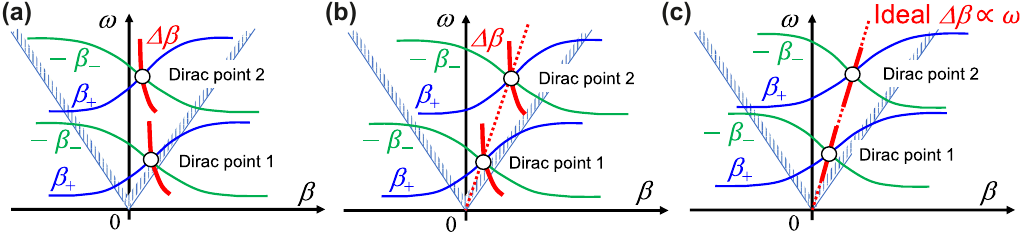
Figure 1: Schematic of typical dispersion diagrams of dual-band CRLH lines with two Dirac points and frequency dependence of the phase- shifting nonreciprocities Δ β . We here consider two conditions. Condition I is the case where both Dirac points in the lower and higher CRLH passbands are on the same linear line passing through the origin. Condition II is the case where both tangents of phase-shifting non- reciprocities Δ β at two Dirac points are proportional to the